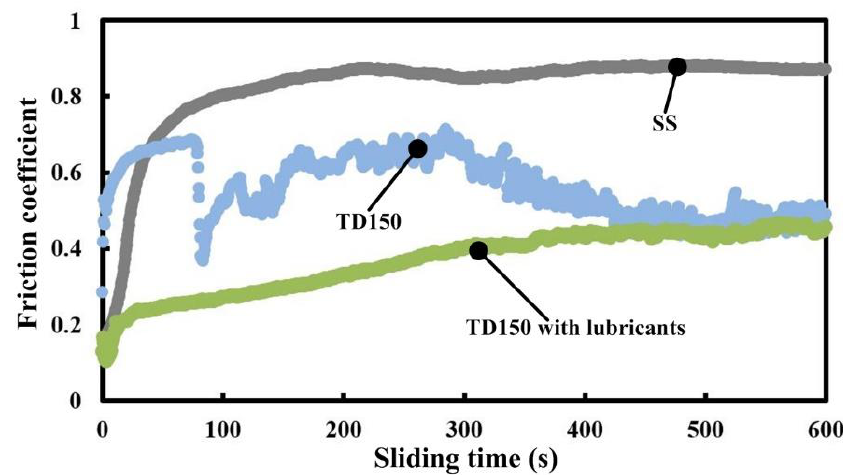
Figure 4. Variations of friction coefficient of different samples at sliding speed of 40 m/min. The average value of the fluctuant friction coefficient obtained in friction operation was calculated and taken as the average friction coefficient for each sliding process. The average friction coefficients of three kinds of samples (SS, TD150 and TD150 with